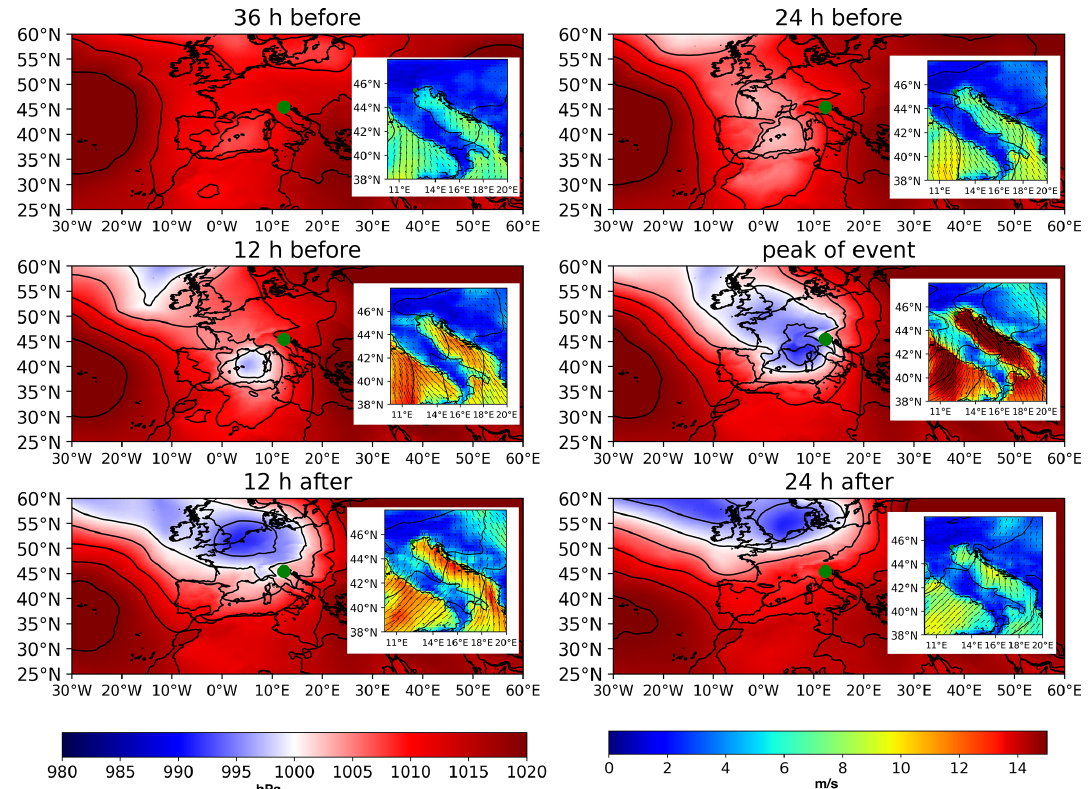
Figure 4. Large panels show the composite of MSLP fields based on ERA5 (hPa; left colour bar) datasets associated with storm surges higher than 50cm in Venice (see Table 1). Small panels show the corresponding wind fields over the Adriatic Sea (ms − 1 ; right colour bar). The time lags chosen for the composites are 36, 24, and 12h before and 12 and 24h after the peak of the event. The green dot shows the location of the city of